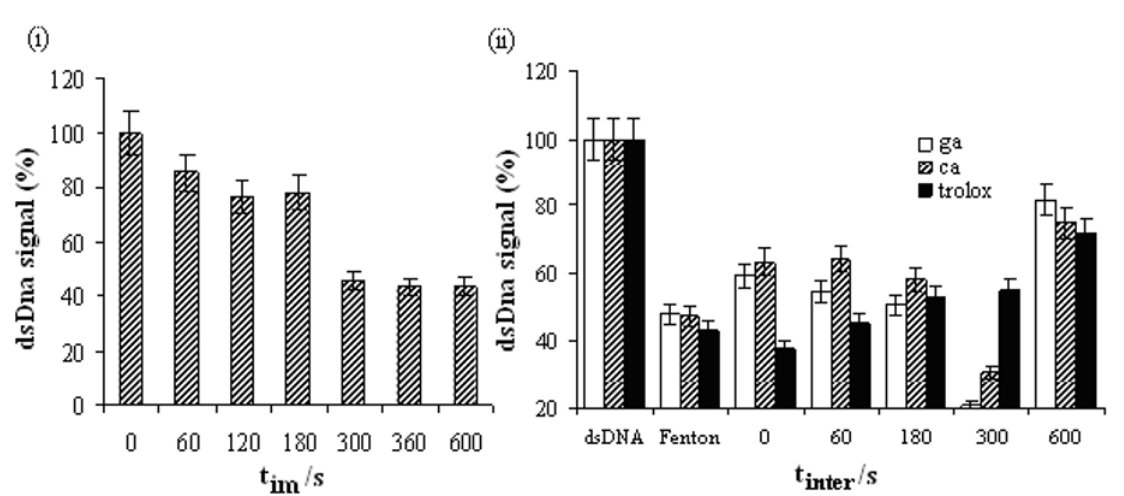
Figure 6. Effect of the (i) immersion time (t ) of the dsDNA modified electrode in Fenton’s cleavage mixture on the oxidative damage of guanine im and (ii) interaction time (t ) between phenolic acids and Fenton’s cleavage mixture on the protection towards guanine oxidation. inter Table 1. Optimized conditions and analytical results of the determination of the studied phenolic acids with DPV. c i a c li o n e h P